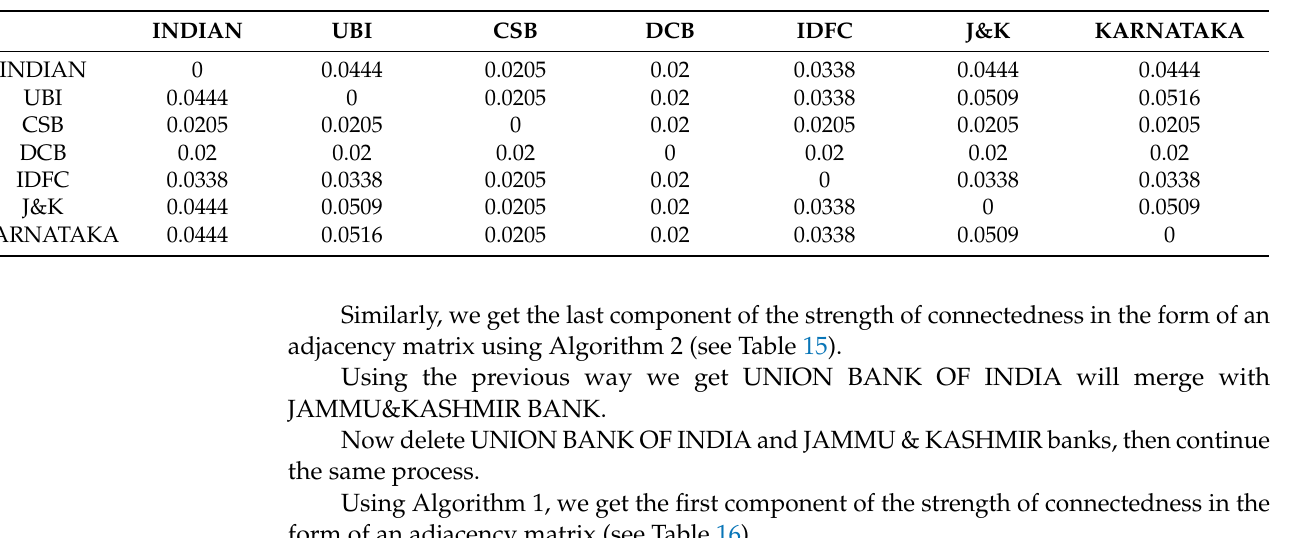
Table 14. Adjacency matrix of the strength of connectedness (1st component): reduced list of 7